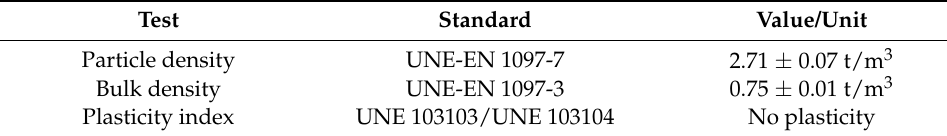
Figure 4. Laser diffraction particle size analysis of ladle furnace slag particles. Table 5. Density and plasticity tests for the fine portion of ladle furnace